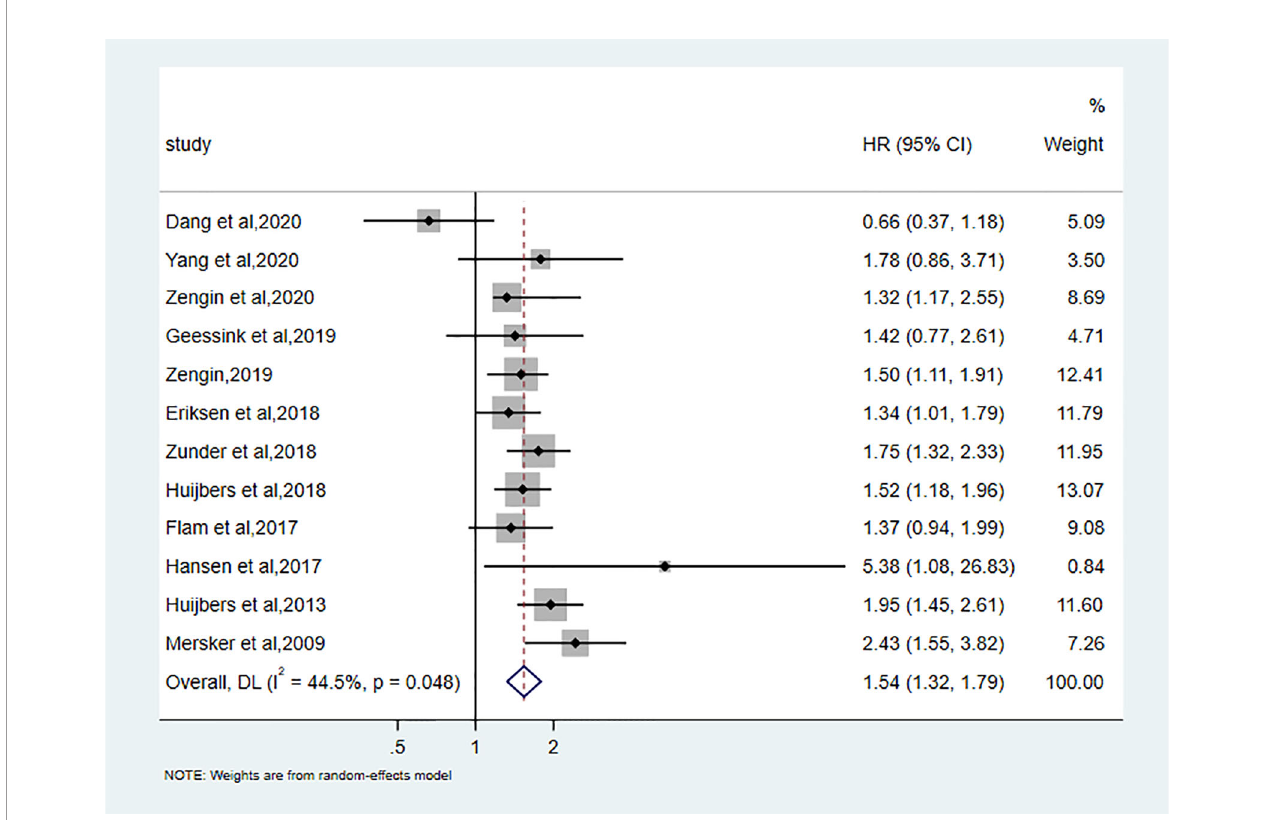
FIGURE 2 | Forest plots for